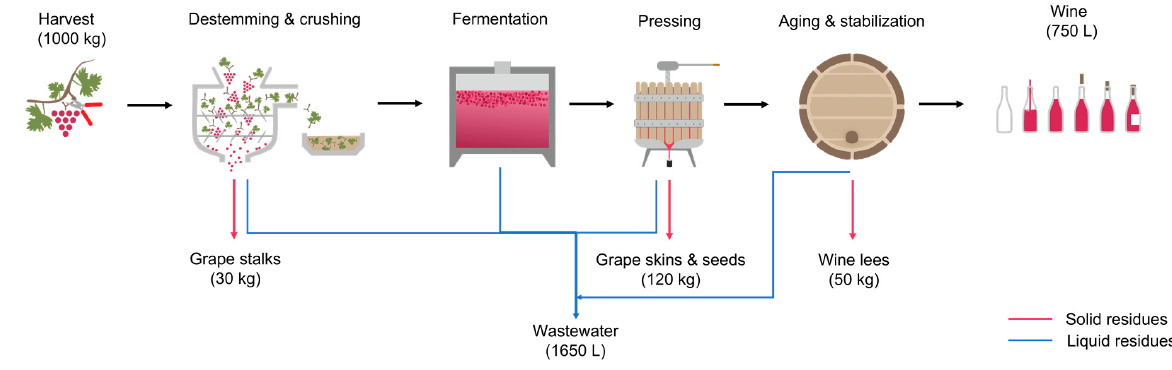
Figure 1. Schematic representation of red winemaking